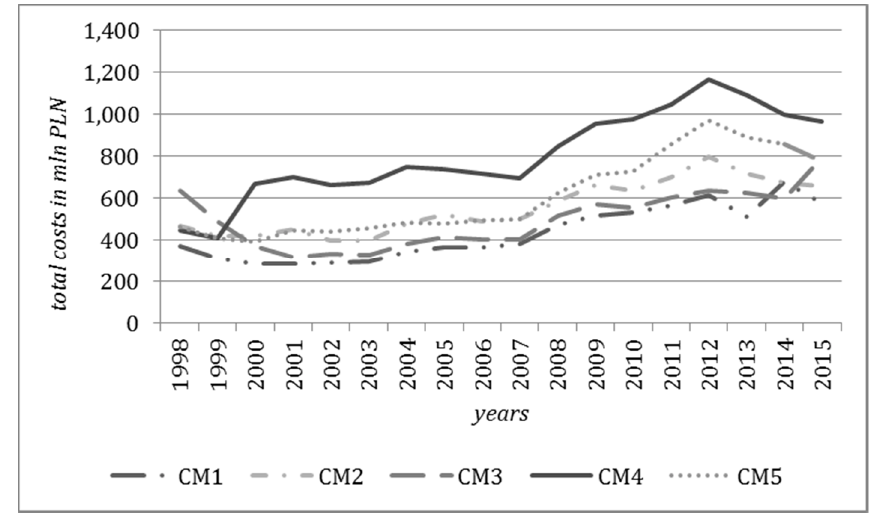
Figure 2. Total production costs of examined coalmines in constant prices of 1998 (mln PLN—Polish New Zloty, the national currency of Poland). Source: own work.